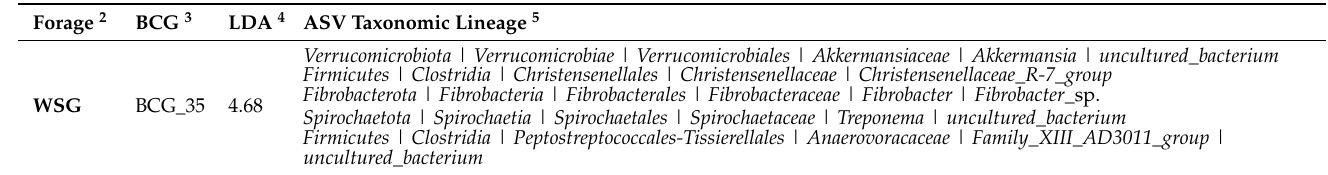
Table 5. Bacterial co-abundance groups (BCG) 1 identified as markers 2 of standardized hay